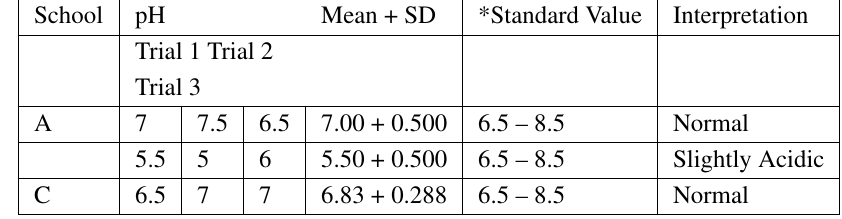
Table 5. pHof water samples from WVMs from public schools in Cebu